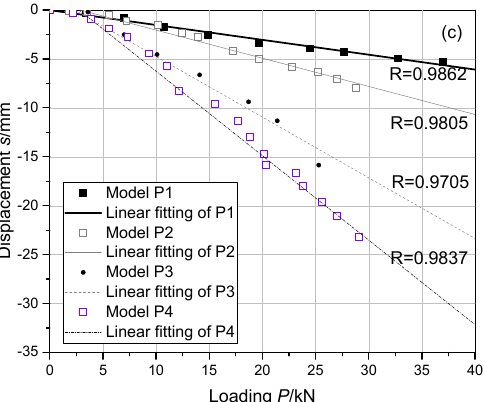
Figure 18. Linear fittings of the static loading test P – s curves during the initial loading stage: ( a ) spread foundation; ( b ) caisson foundation; and ( c ) grouped pile foundation.